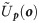
Transformed utility U˜p(o) (25) for different values of Dp≔pD2(r=1).Black star points indicate the location of the inflection points or*(Dp), where the function changes the sign of its concavity.